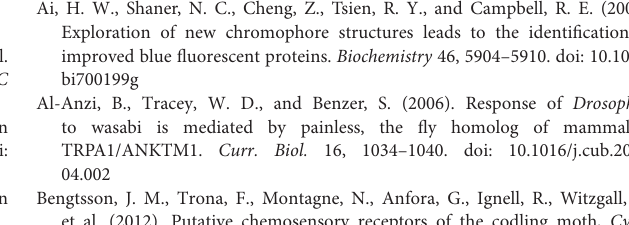
Supplementary Figure 1 | Gene ontology of P. hospiton assembly. Gene Ontology (GO) terms retrieved for biological process (upper panel) and molecular function (lower panel) using top blastx hit against D. melanogaster and Panther v14.0. Lower level GO terms were selected to illustrate sensory perception-related functions present in the assembly. Supplementary Figure 2 | Phylogeny of P. hospiton maxilla-expressed sensory neuron membrane proteins (SNMPs). A maximum-likelihood tree was built with selected SNMP sequences from Zhang et al. (2020) using RAxML. Branch lengths are scaled by the number of nucleotide substitutions per site. Dple Danaus plexippus ; Bmor Bombyx mori , Harm Helicoverpa armiger a; Sexi Spodoptera exigua . Supplementary Figure 3 | Phylogeny of P. hospiton maxilla-expressed odorant-binding proteins (OBPs). A maximum-likelihood tree was built with selected OBP sequences from Vogt et al. (2015) using RAxML. Branch lengths are scaled by the number of nucleotide substitutions per site. Bootstrap values refer to 500 pseudo-replicates. Supplementary Figure 4 | Supplementary functional studies on TRP-Painless. Mean ± SE of fluorescence variation associated with PhospPain and PmachPain upon testing different Petri dishes to a set of stimulus, including cold (T ∼ 9–10 ◦ C; PhospPain, N = 110; PmachPain, N = 108), hydrogen peroxide (H 2 O 2 ; PhospPain, N = 88; PmachPain, N = 111) and an essential oil extracted from Ruta graveolens diluted in Ringer buffer at 150 µ g/mL (PhospPain, N = 92; PmachPain, N = 94). The existence of a similar effect on un-transfected HEK293A cells recorded upon the cold stimulation suggested a possible involvement of other endogenous mechanisms, most probably based on the effects of cold-associated Calcium release from the endoplasmic reticulum (Reddish et al., 2021). 3.0% H 2 O 2 was the maximum concentration used. Below: negative control testing untransfected HEK293A cells with cold ( N = 80). Black bars: stimulus (20 s). Supplementary Table 1 | List of primers to amplify Papilio OR1 and Pain. Supplementary Table 2 | De novo assembly statistics. Supplementary Table 3 | Cell percentages based on fluorescent features. Percentages of fluorescent cells were based on EBFP expression (EBFP+) and fluorescence induced by 500 µ M VUAA1 application (Fluo4+) from different HEK293A-samples transfected with CpomOrco and CpomOrco+OR (PmachOR1, PhospOR1, and CpomOR3). For CpomOrco+OR3, plot of the mean response to 1000 µ M pear ester ( N = 134; 26,02%) is shown in Figure 5B . Data from previous analysis conducted in the frame of parallel experiments are reported for the wild-type CpomOrco, the mutagenized CpomOrco (CpomOrcoQ417H),